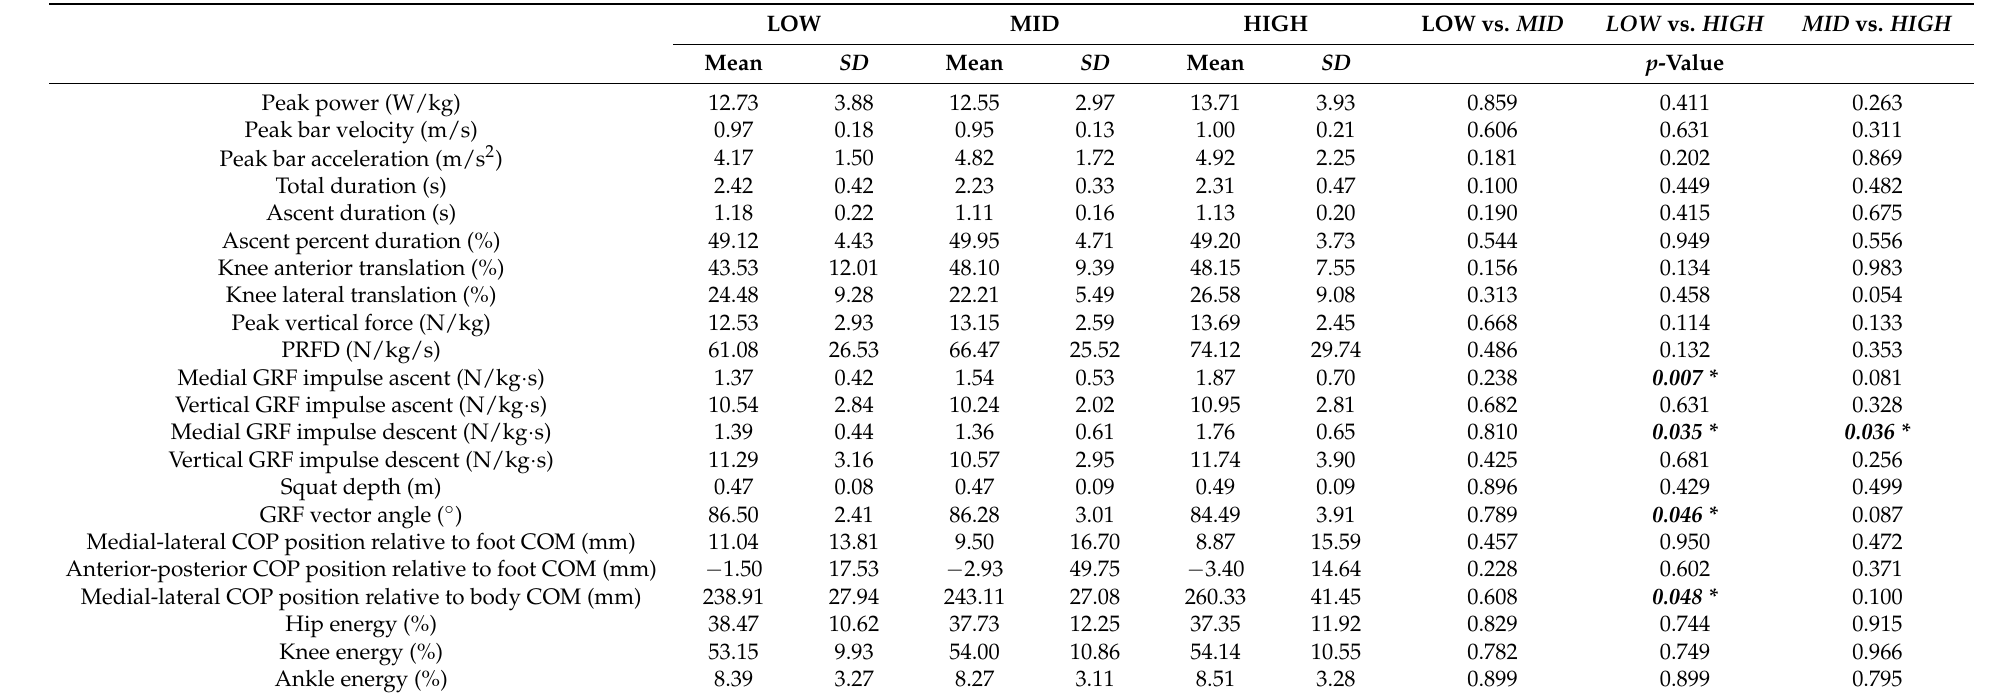
Table 1. Kinetic and temporal parameters (mean ± SD) and statistical comparisons as a function of each experimental group. LOW MID HIGH LOW vs. MID LOW vs. HIGH MID vs.